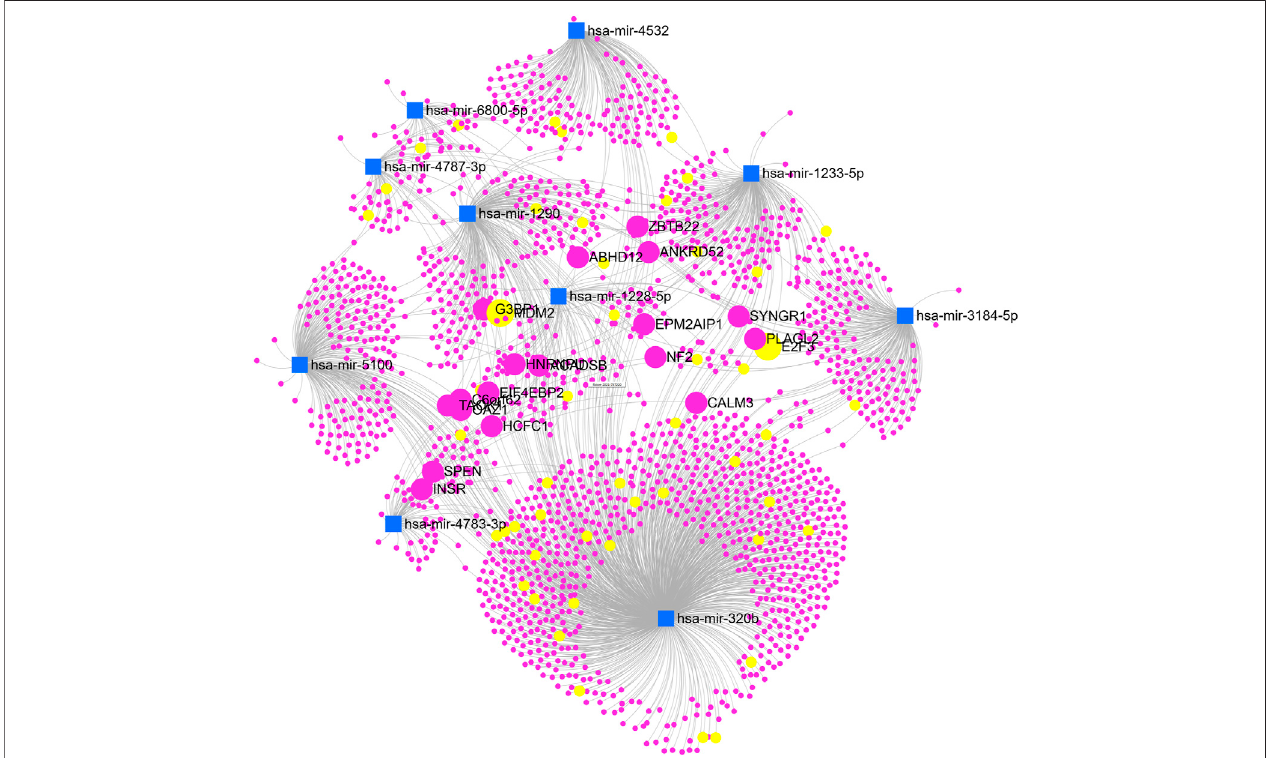
FIGURE 6 | The miRNA network with target